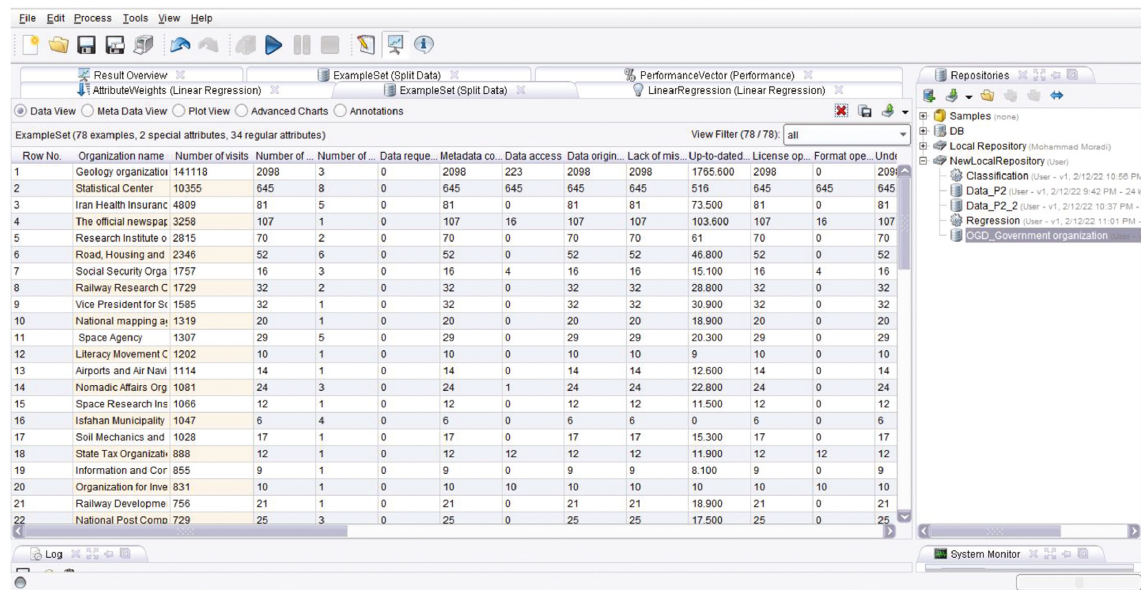
Figure 7: Training data.